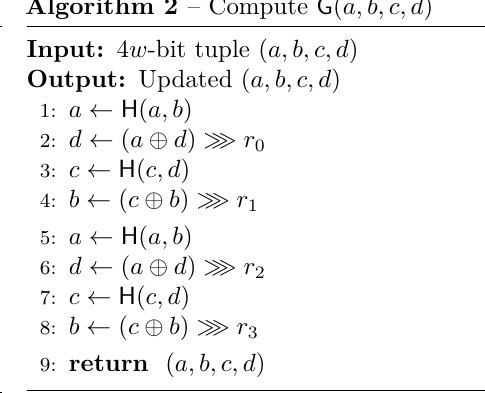
onals. Algorithm 2 – Compute G ( a, b, c, d )